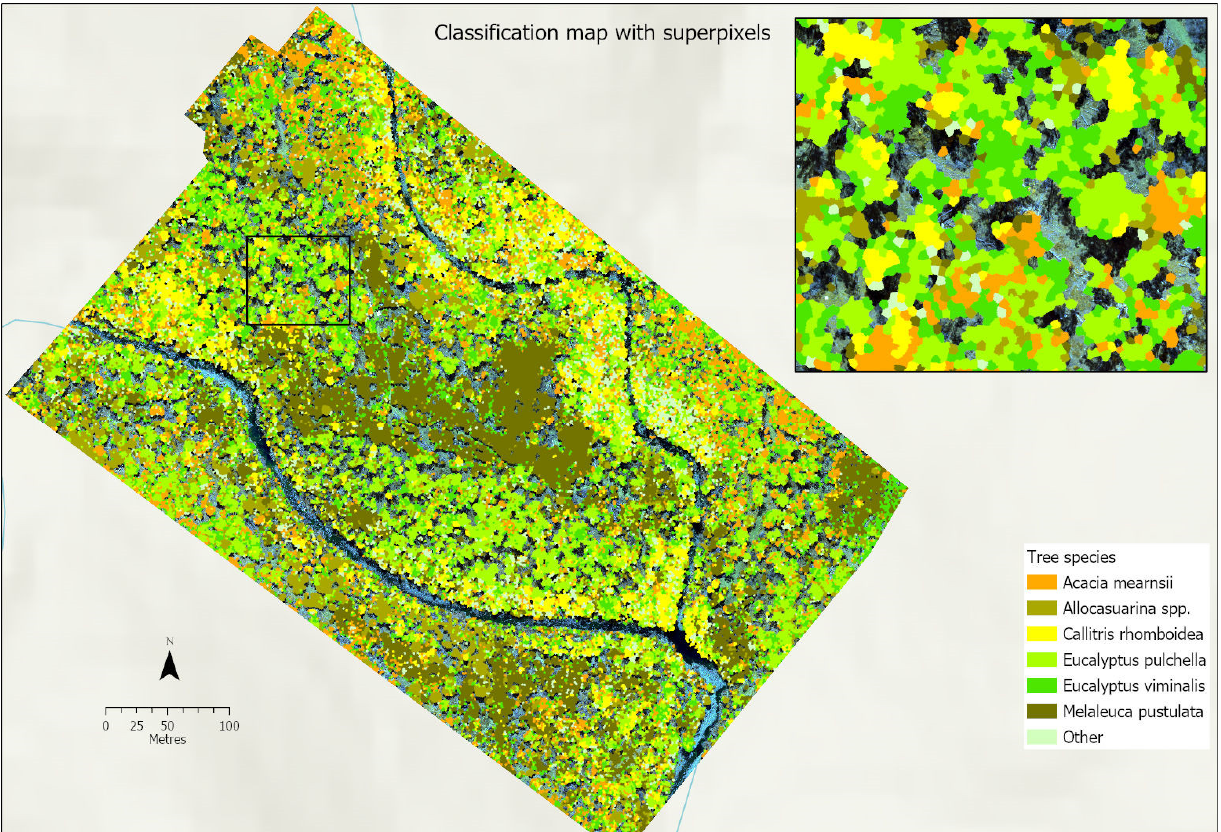
Figure 8. Classification map using superpixels. Inset shows classification in a Pulchella dominated forest subset. While the highest classification accuracy was achieved with superpixels, speckle effect is evident across the site at this scale. For example, canopy edges and shadow areas are misclassified as other species.